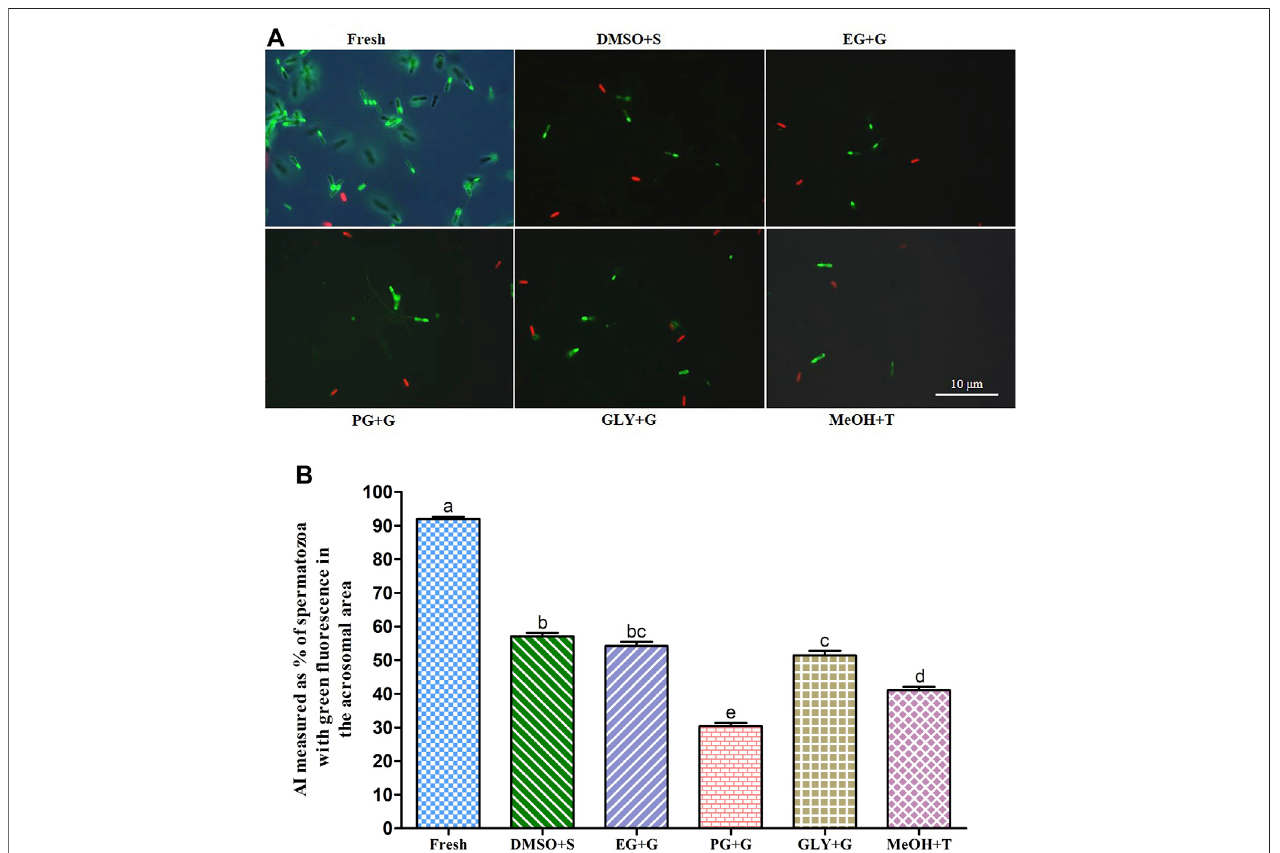
FIGURE 3 | Effects of saccharides (sucrose, glucose, and trehalose) on acrosome integrity (AI) of post-thaw sperm. (A) LYSO-G/PI-stained images of fresh and cryopreserved sperm. (B) AI values of different types of post-thaw sperm. Results are presented as mean values ±standard deviation ( n = 10). DMSO + S: 8% dimethyl sulfoxide(DMSO)combined with3%sucrose(S),EG+G:8%ethyleneglycol(EG)combinedwith1%glucose(G),PG+G:6%propyleneglycol (PG)combinedwith2% glucose (G), GLY + G: 2% glycerol combined with 3% glucose (G), and MeOH + T: 2% methanol (MeOH) combined with 4% trehalose (T). Signi fi cantly different levels ( p < 0.05) are denoted by different